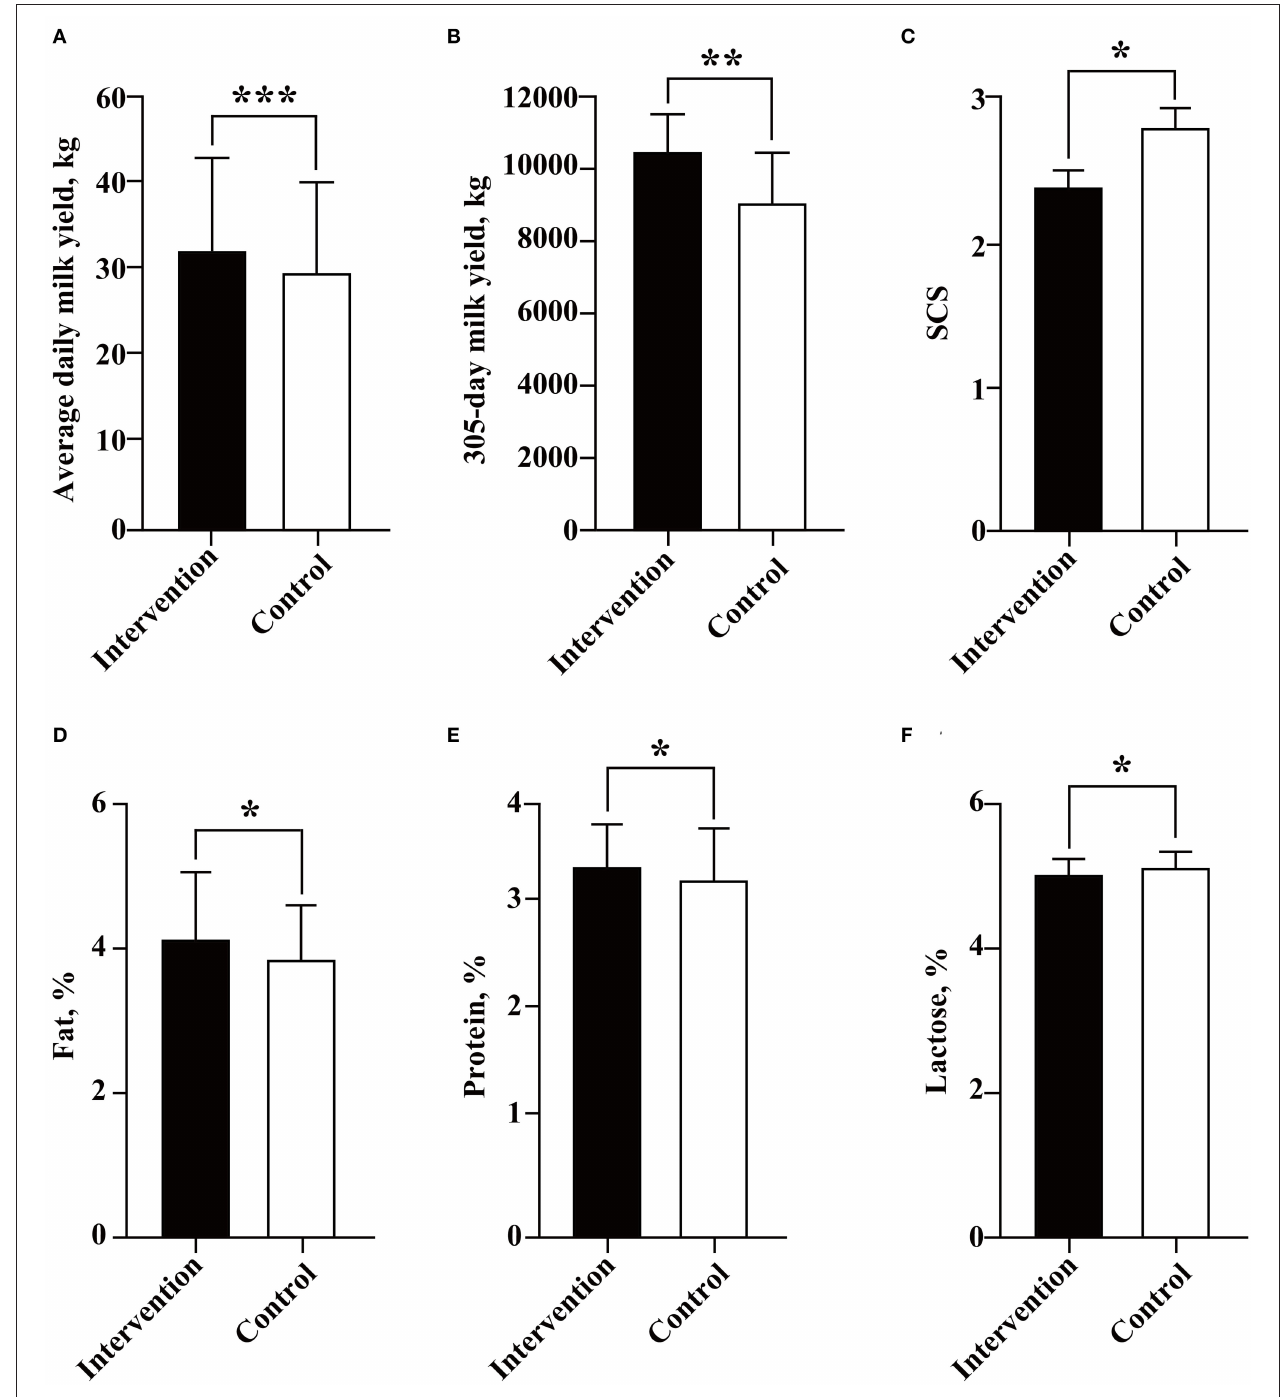
FIGURE 3 | Association between BLV infection and dairy performance of cows. The average daily milk yield (A) , 305-day milk yield (B) , SCS (C) , and contents of fat (D) , protein (E) , and lactose (F) were compared and analyzed between the intervention (in black) and control (in white) groups by Student’s t -test. Data are shown as mean ± SD, and the symbols indicate P ≤ 0.001 (***), P ≤ 0.010 (**), and P ≤ 0.05 (*), respectively.